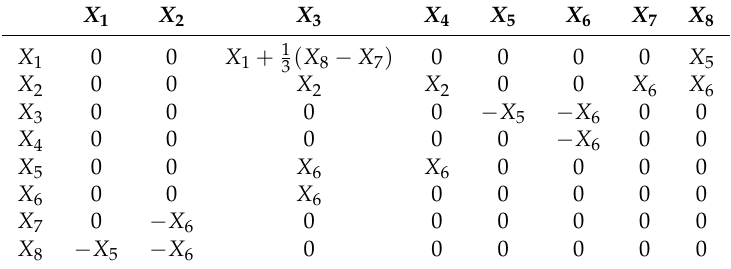
Table 1. Approximate commutators of approximate symmetry of the perturbed non-linear wave equation. X